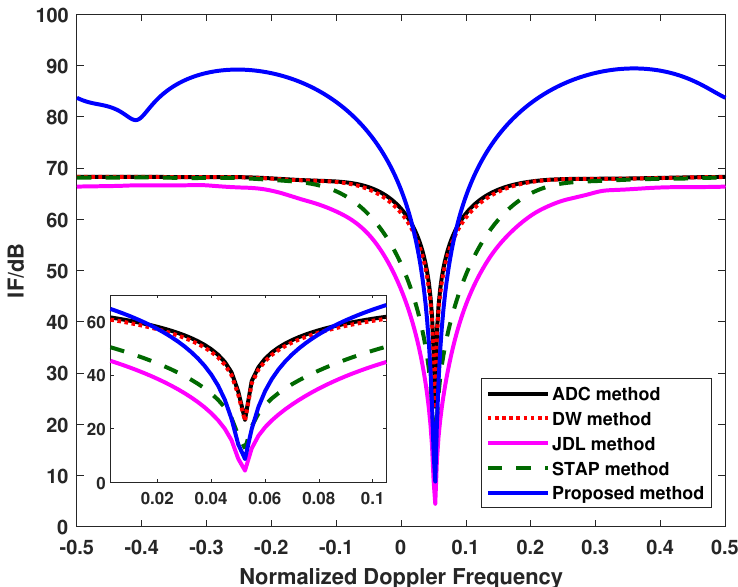
Figure 5. IF versus normalized Doppler frequency for different platform parameters. Figure 6 verifies the IF versus normalized Doppler frequency for different methods, where a side-looking radar with ϑ = 0 ◦ , and different clutter-to-noise ratios CNR = 40 dB and CNR = 60 dB are considered. As shown in Figure 6, for all the methods, an increase in CNR corresponds to an improvement in IF. For different CNRs, compared with the other methods, the proposed method provides the narrowest and deepest IF notch. The obvious superiority of the proposed method results from the designed p -dimensional ˜ˆ C r matrix based on the processed and selected covariances; meanwhile, it results from re its automatic encoded and decoded reconstruction that compresses the characteristics of CNCM and abandons the deviations caused by the non-uniformity and the deficiency of training samples.